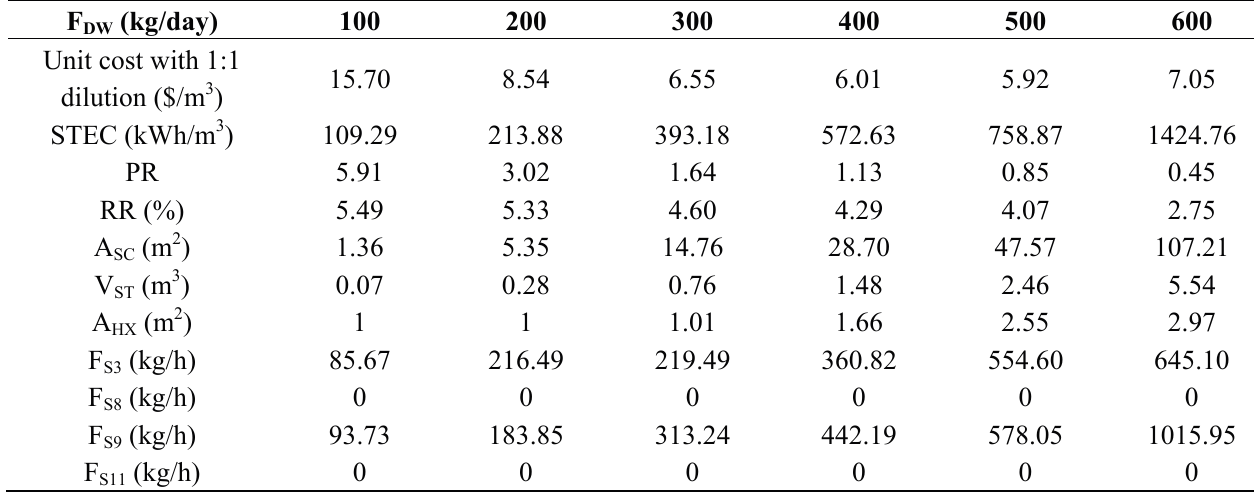
Table 3. Optimal solutions for the AGMD-1 system. STEC, specific thermal energy consumption; PR, performance ratio; RR, recovery